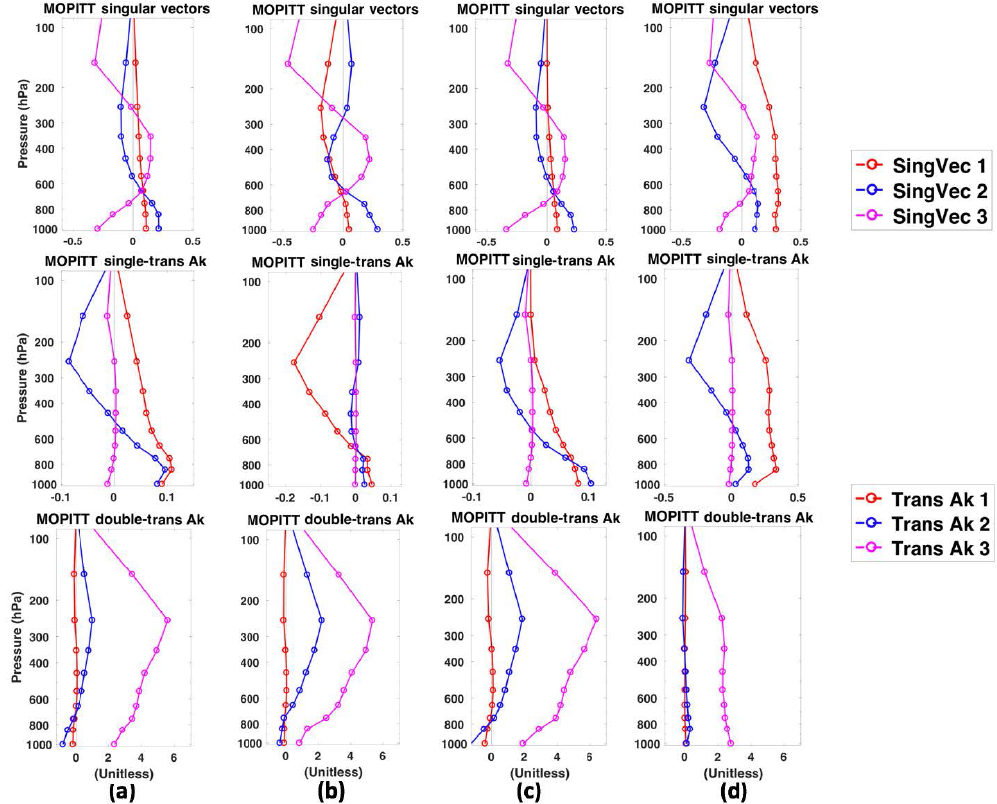
Figure 4. Composite vertical profiles for the (i) leading left singular vectors of the MOPITT CO averaging kernels in the upper row, (ii) com- pressed averaging kernels in the middle row, and (iii) rotated and compressed averaging kernels in the lower row. The DOFS ranges are the same as defined for Fig. 2. For the profile labels, “SingVec x” refers to ranked singular vectors, where x = 1 is the first leading singular vector, x = 2 is the second leading singular vector, and so forth. “Trans Ak x” refers to the compressed or rotated and compressed averaging kernel profile associated with the QOR and CPSR mode x,